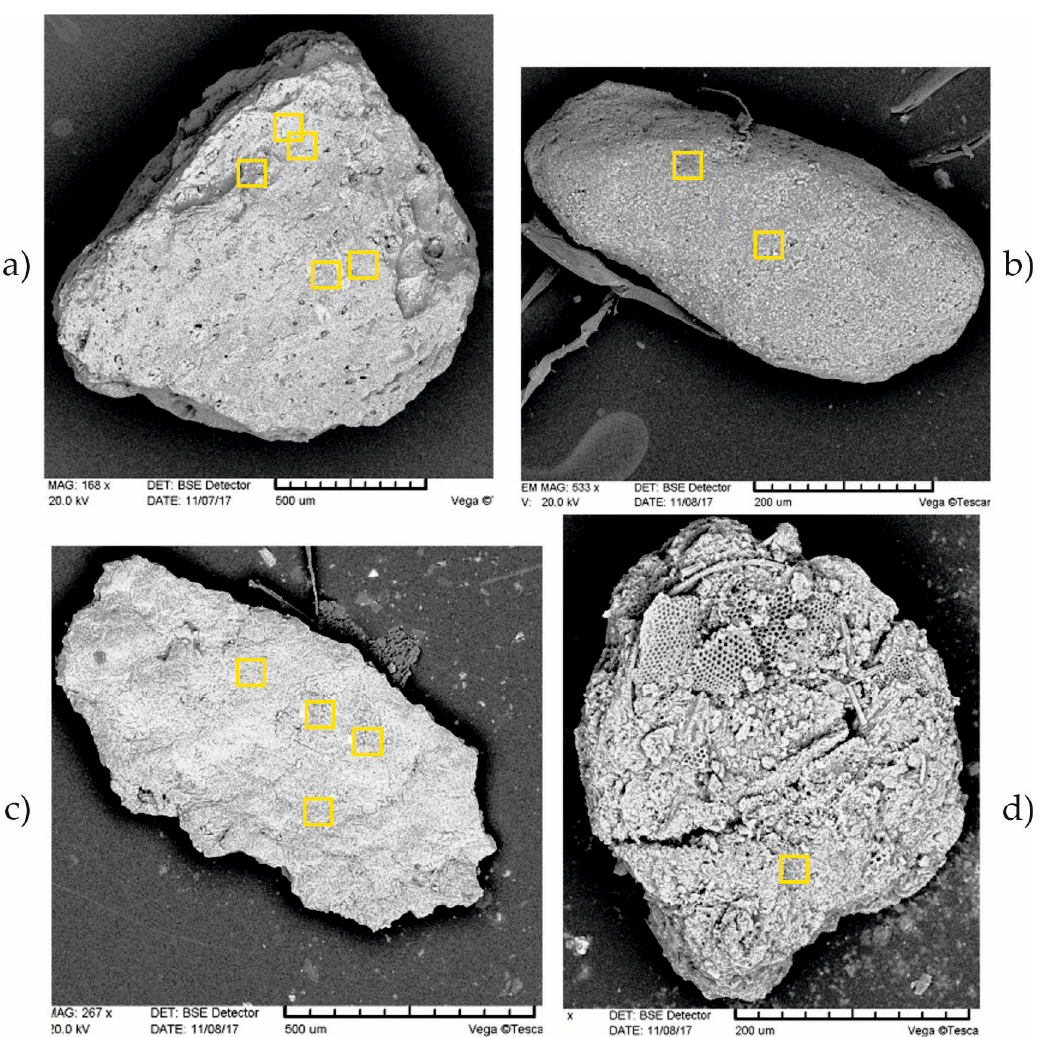
Figure 6. Scanning electron microphotographs of the andesitic ash shards and pisolites from the core unit of 323–340 cm: ( a ) rounded fine-pored black heterogeneous andesitic shard with a SiO 2 content of 53.30–53.66% in the sample of 323–325 cm; inclusions are the sheet-like fragments with a higher SiO 2 content of 55.50–56.05% and small ilmenite crystals; ( b ) light pisolite which is composed of the andesitic basalt ash dust with a SiO 2 content of 62.03–65.98% in the sample of 323–325 cm; inclusions are small titanomagnetite crystals; ( c ) unconsolidated grain of light color which is composed of the andesitic basalt ash dust in the sample of 328–330 cm; inclusions are small ilmenite and titanomagnetite crystals; ( d ) white pisolite which is composed of the diatom frustules fragments and volcanic dust in the sample of 328–330 cm. Yellow-outlined rectangles show points of measurements. Pisolites were found as semi-rounded/non-rounded grains, black, and composed of the andesitic